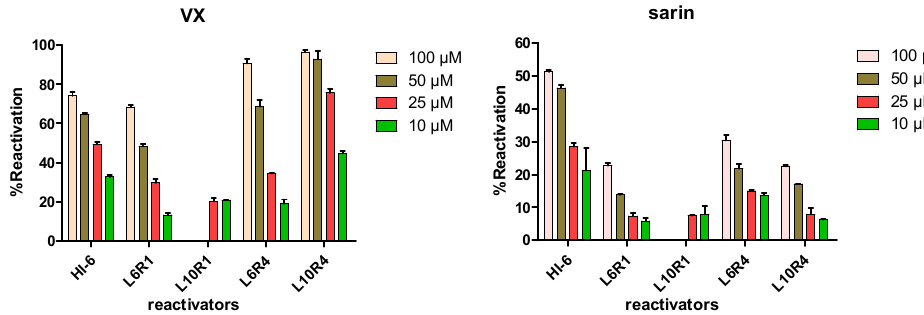
Figure 2. Chemical structures of non-oxime reactivators.